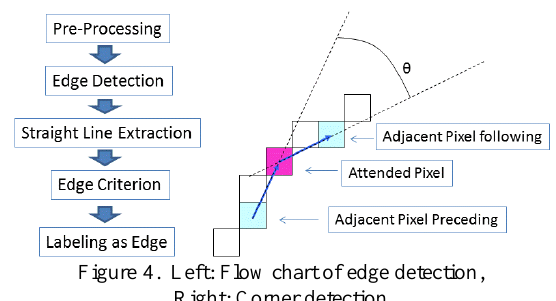
Figure 4. Left: Flow chart of edge detection, Right: Corner detection